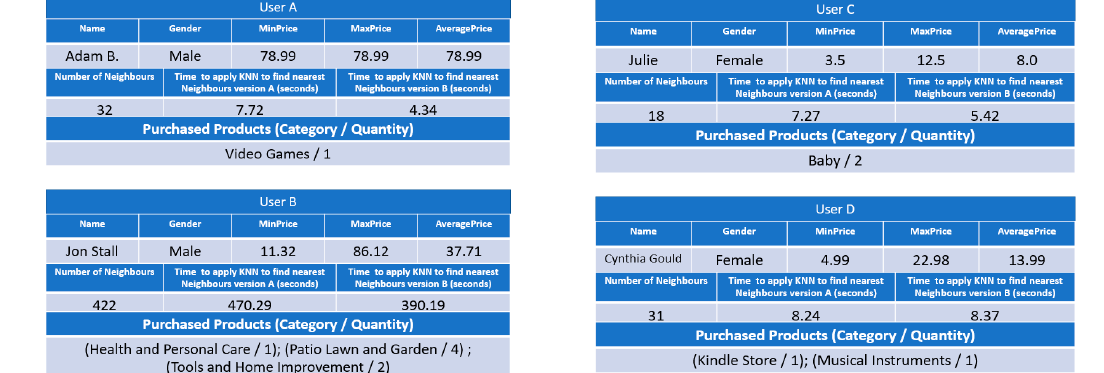
Figure 5. User Profiles to experimental evaluation.